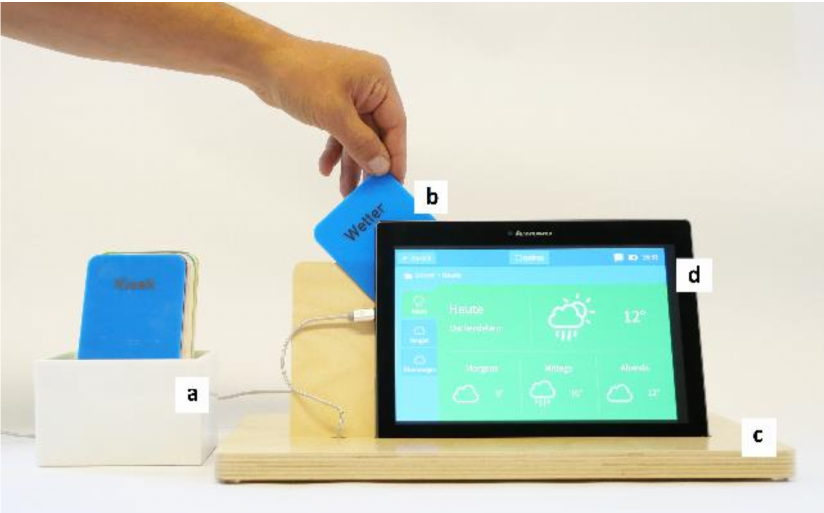
Figure 2. ( a ) SmartCards in card holder. ( b ) SmartCard in application rail. ( c ) Tablet holder made of wood. ( d ) Tablet PC with asina personal desktop. Photograph by Julia